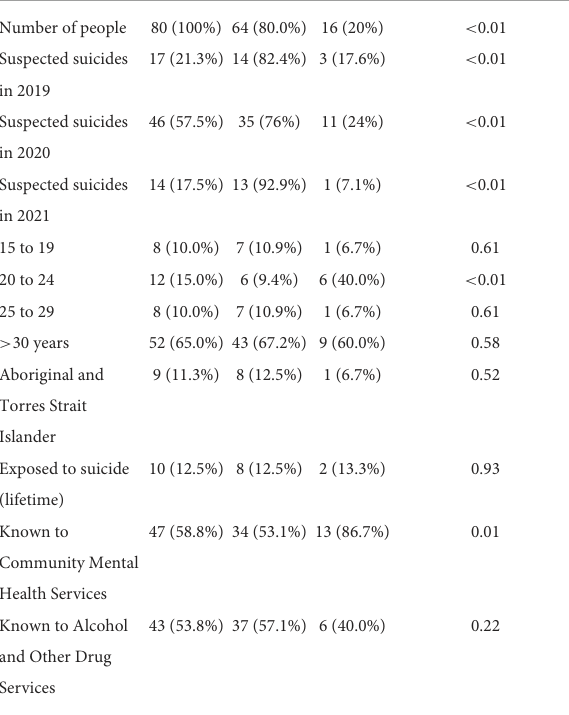
TABLE 2 Characteristics of those who died by suspected suicide in the PaRK region, 2019 to 2021. Characteristics Total Male Female Chi square p -value